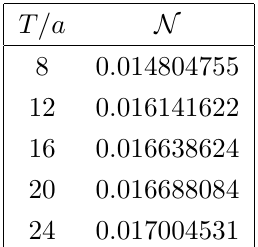
Table 4 . Normalisation factors for the renormalised coupling (cid:8) 1 in the SF with tree level improved L(cid:127)uscher-Weisz gauge action, T = L and vanishing background (cid:12)eld.